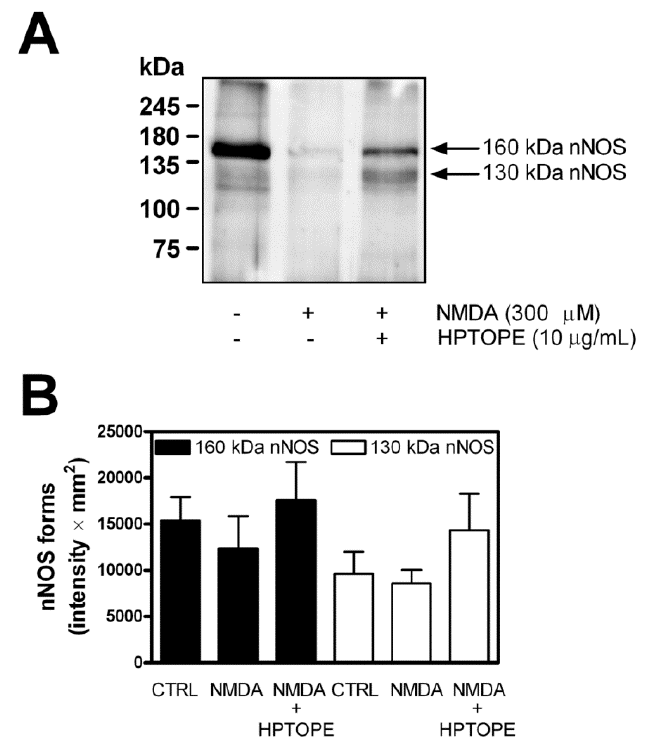
Figure 6. Evaluation of neuronal nitric oxide synthase (nNOS) in cortical neurons following NMDAR stimulation in the presence of HPTOPE. After 14 DIV, neurons were incubated for 4 h with the indicated stimuli. Aliquots of total proteins from neuron lysates were submitted to 8% SDS / PAGE followed by immunoblotting for nNOS. ( A ) A representative blot of nine is shown. ( B ) Relevant immunoreactive bands were quantified, normalized vs. β -actin signal, and reported as intensity × mm 2 . Data are means ± SEM from nine independent experiments.